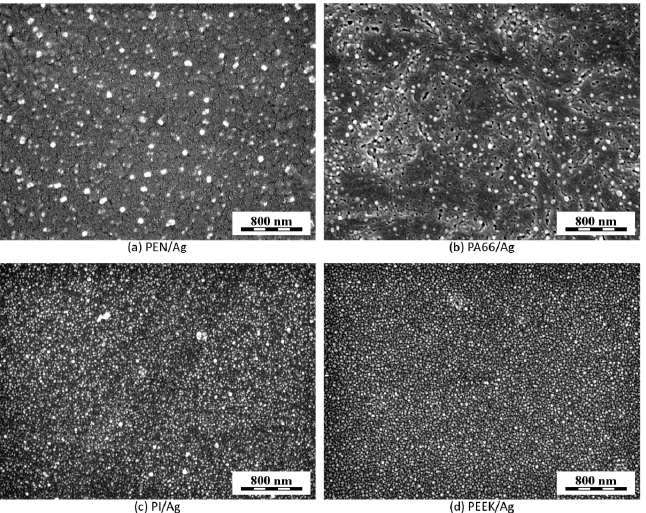
Figure 9. FEGSEM micrographs of surface morphology of polymers immobilized with AgNPs (laser fluence 14 mJ cm − 2 ): PEN ( a ), PA66 ( b ), PI ( c ), and PEEK ( d ). All micrographs were recorded with in-beam SE detector at accelerating voltage 3 kV.